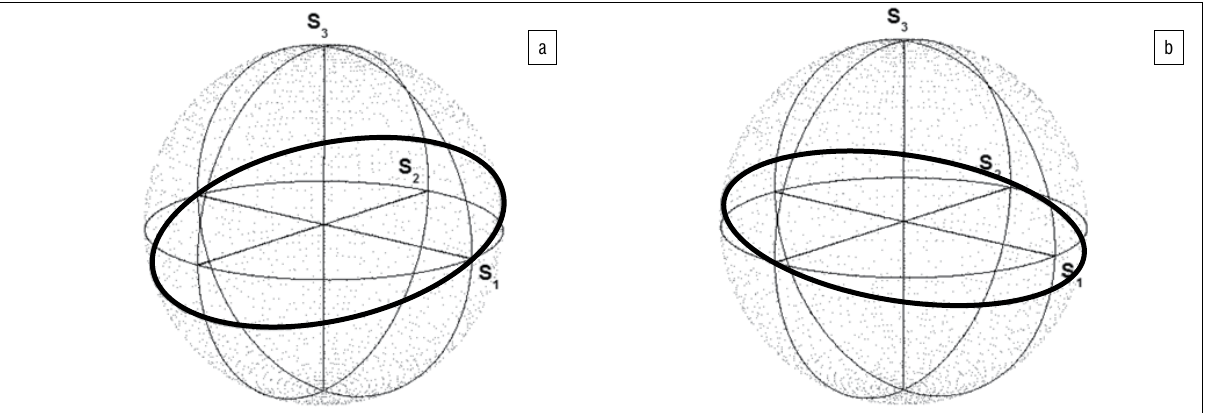
Figure 4: In (a), the bold line shows the measured states of polarisation (SOPs) of the test signal on the Poincaré sphere. The S1 axis represents the rectilinear basis, the S2 axis represents the diagonal basis and the S3 axis represents the circular basis. The measurements show that both the vertical and horizontal SOPs were returned to their original states, even though only the vertical SOP was compensated in this case. Similarly, in (b), both diagonal SOPs were corrected, even though only one of them was compensated for.